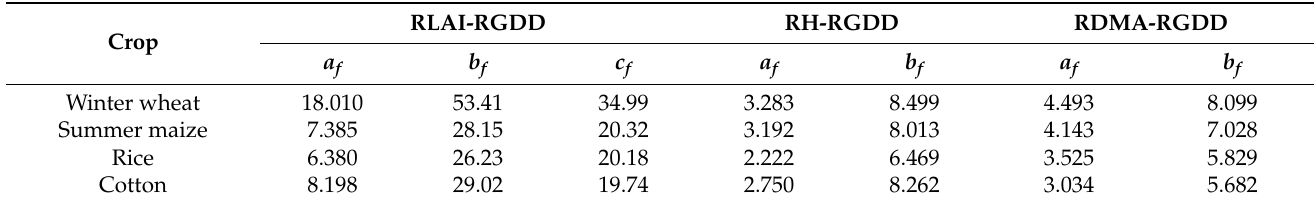
model. c f = 0 in the relationship between RH-RGDD and RDMA-RGDD.